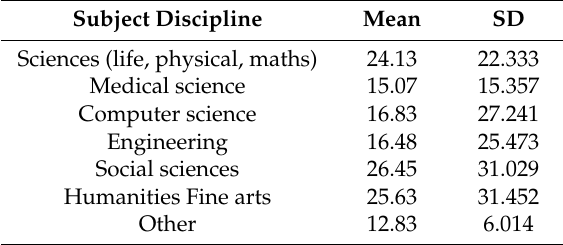
Table 7. Number of article readings by subject disciplines